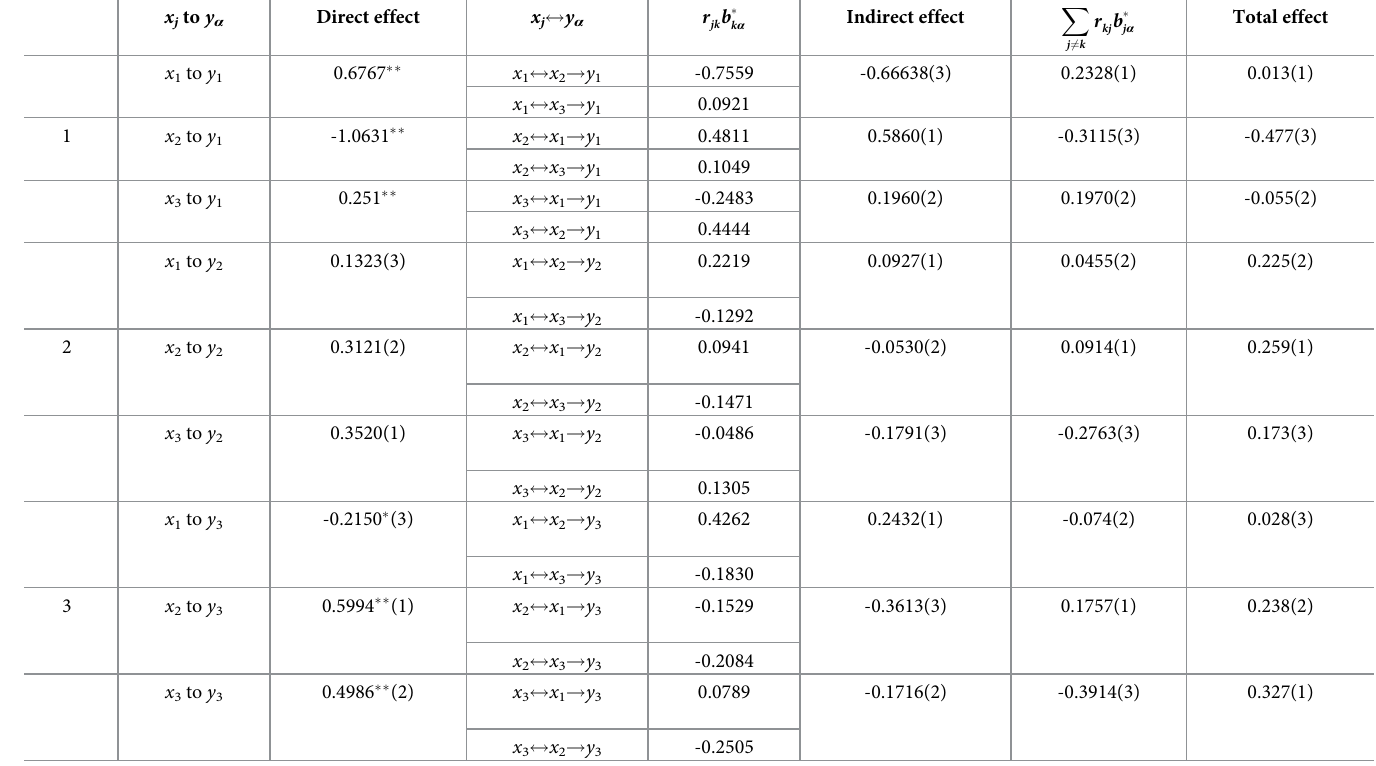
¼ β � T ð α ¼ 1 ; 2 ; 3 Þ . x þ ε α α α